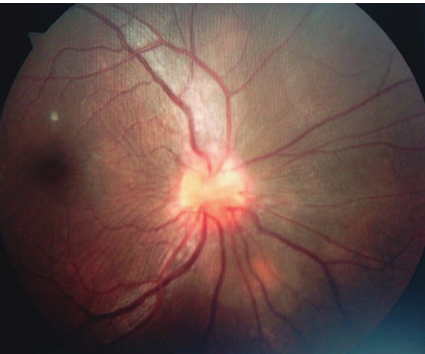
Figure 1: Fundus picture showing a congested right optic disc sug- gestive of AION.